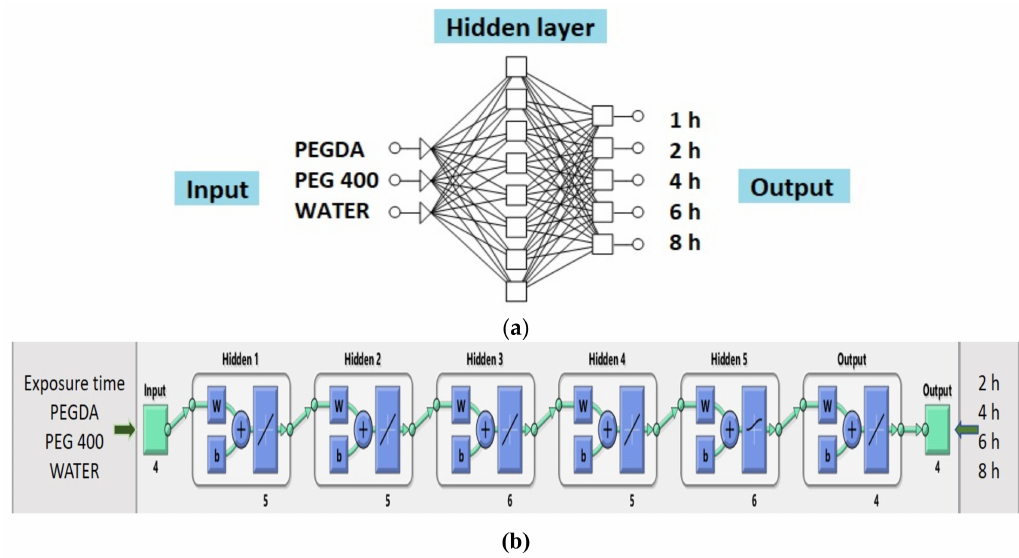
Figure 7. ( a ) Architecture of neural network 1 and ( b ) architecture of neural network 2.